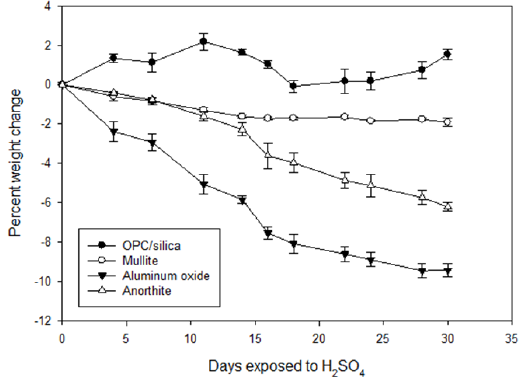
Figure 9. Percent of samples’ weight change in the acid exposure tests (sulfuric acid pH 1, 90 °C) for OPC/SiO 2 , mullite, anorthite, and aluminum silicate samples at different exposure times. The negative numbers signify weight losses and the positive numbers — weight gains.